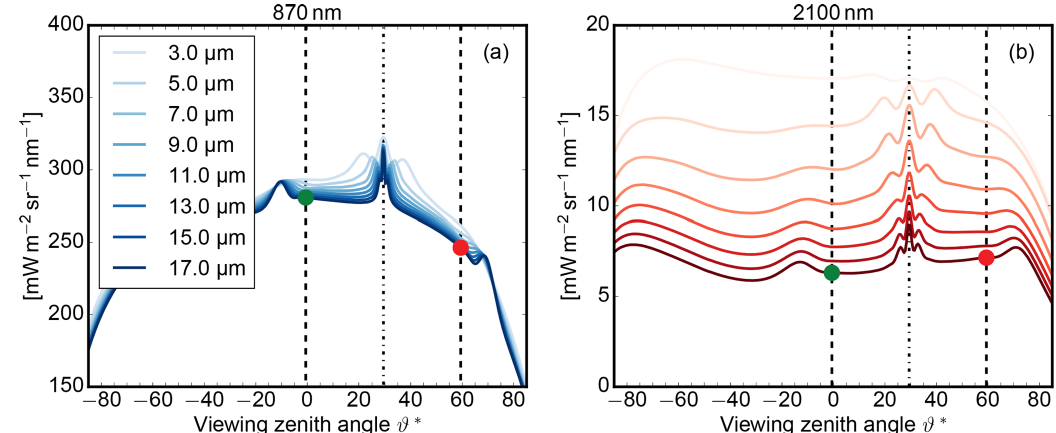
Figure 10. Spectral radiances at (a) λ = 870nm and (b) λ = 2 . 1µm for an optically thick water cloud ( τ c = 500) for different effective radii as a function of relative viewing angle ϑ ∗ for a fixed illumination of ϑ ∗ in Figs. 9, 11, and 12.